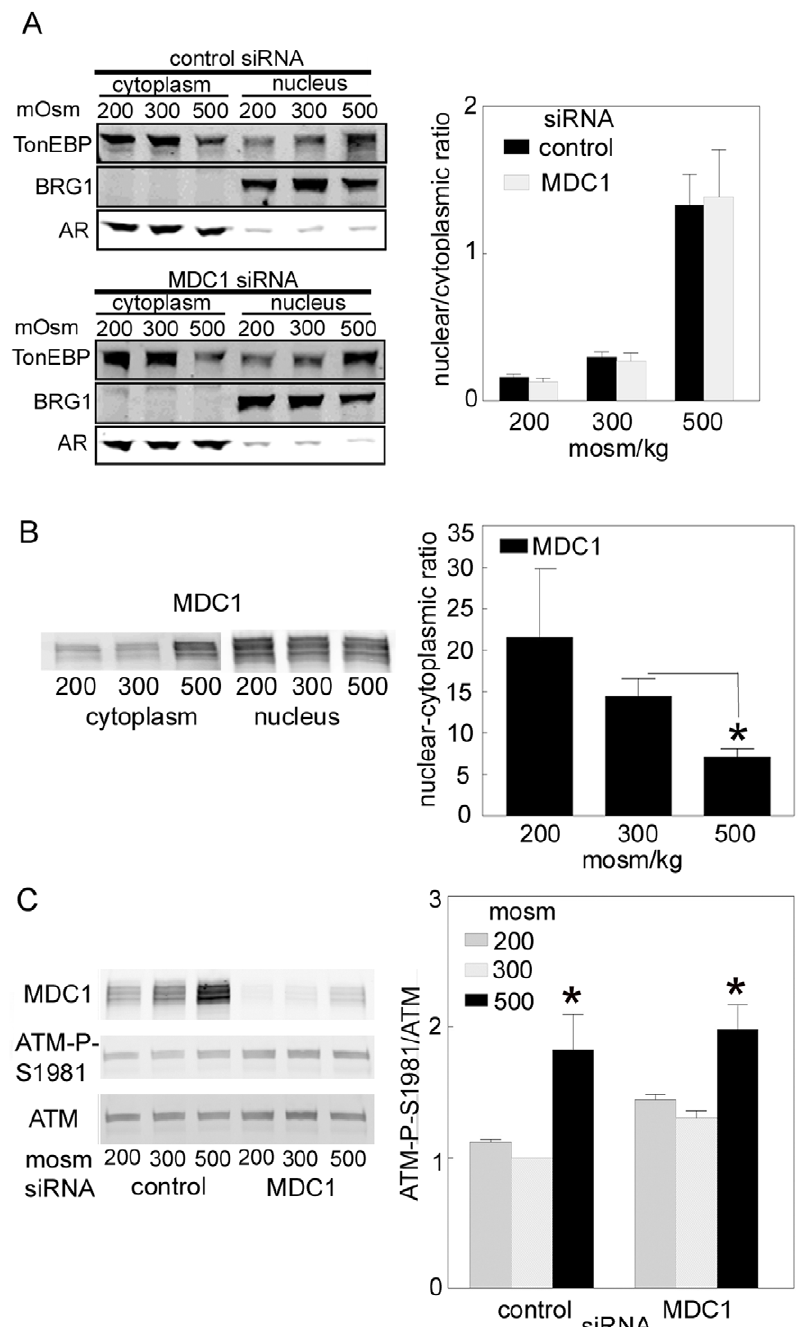
Figure 5. A. Lack of effect of siRNA-mediated knockdown of MDC1 on nuclear localization of TonEBP/OREBP. HEK 293 cells were transiently transfected with 25 nM MDC1 siRNA or control siRNA. 48 h later the osmolality of medium was changed to 200 or 500 mosmol/kg or kept at 300 mosmol/kg for 1 h. Nuclear and cytoplasmic extracts were prepared. TonEBP/OREBP nuclear/cytoplasmic ratio was calculated from its abundance in nuclear and cytoplasmic extracts. Antibodies to BRG1 and aldose reductase serve as controls for nuclear and cytoplasmic fractionation, respectively. B . High NaCl decreases the nuclear localization of MDC1. Osmolality was changed to 200 or 500 mosmol/kg or kept at 300 mosmol/kg for 1 h. Nuclear and cytoplasmic extracts were prepared. MDC1 nuclear/cytoplasmic ratio was calculated from its abundance in nuclear and cytoplasmic extracts. C. Lack of effect of siRNA-mediated knockdown of MDC1 on phosphorylation of ATM on Ser1981. As in (A), except that abundance of ATM was measured in whole cell extracts by Western analysis using a non-phosphospecific antibody and its phosphorylation on Ser1981 was measured using phosphospecific anti-ATM 1981S-P antibody. Results are presented as the ratio of phosphorylated to non phosphorylated ATM. (* P , .05, compared to 300 mosmol).